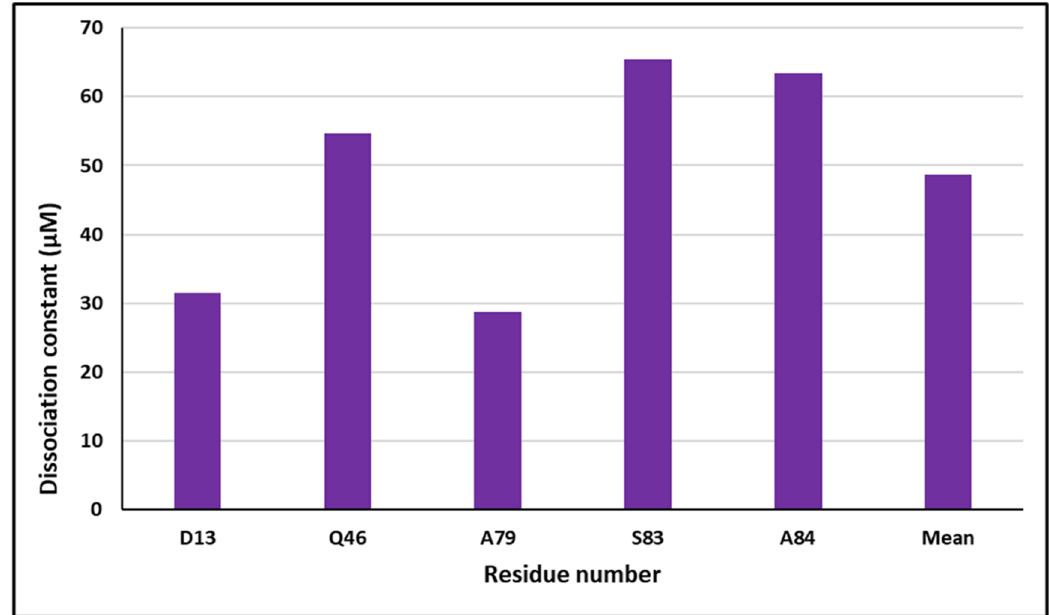
Figure 5. The dissociation constant (K d ) measured using the specified residues found in pentamidine titrations with 15 N S100P HSQC, and the overall average K d was 48.74 μ M as indicated with a broken line.